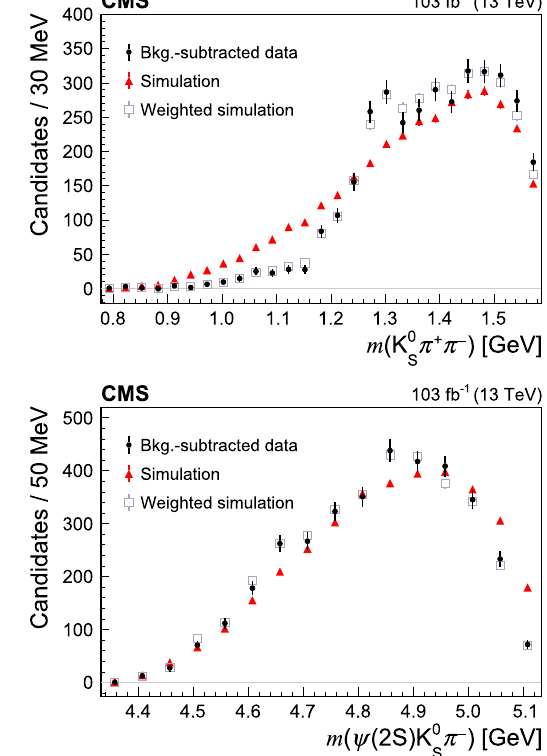
ulations (red triangles), as well as the predictions after applying the reweighting procedure described in Sect. 7 (grey